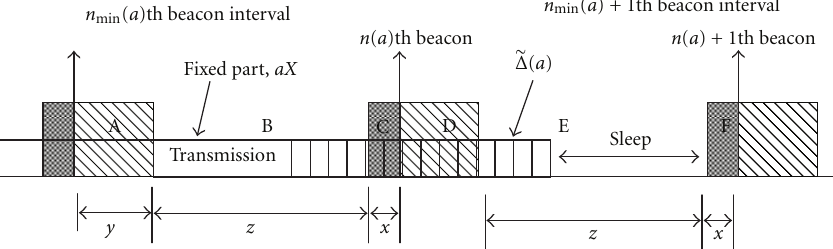
Figure 7: The safety margin and awake-window area are shown by deep hatched and light hatched, respectively. Here T = 102 . 4 ms, y = 5ms, x = 0 . 1024 ms, and z = 97 . 29 ms. Based on awake window and safety margin beacon interval n ( a ) and n ( a ) + 1 are divided into 6 regions A to F. The deterministic part and indeterministic part of a transmission is also shown here separately.